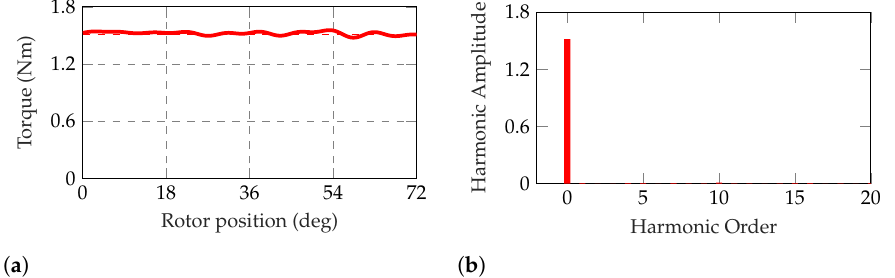
Figure 24. Torque waveform and harmonic content of the 12/10 spoke-type PM motor, experimen- tal results. ( a ) Torque waveform. ( b ) Harmonic